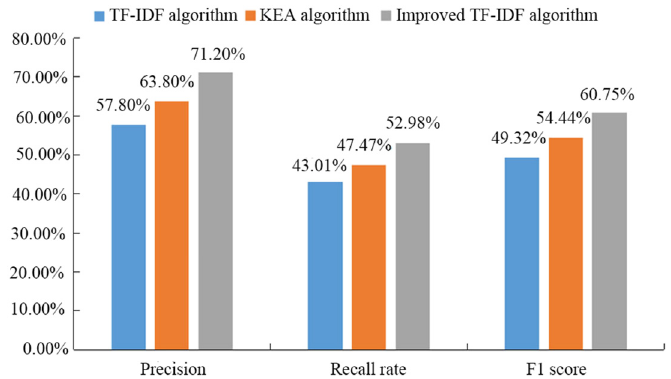
Figure 1: Performance comparison between algorithms when extracting fi ve keywords from each